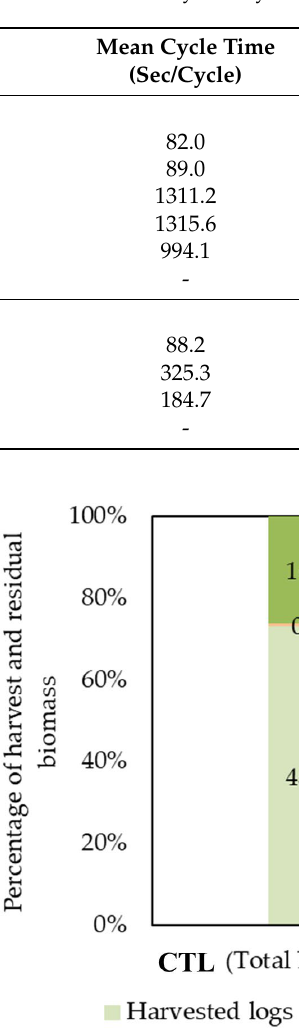
Table 6. Mean delay-free cycle time by harvesting systems.